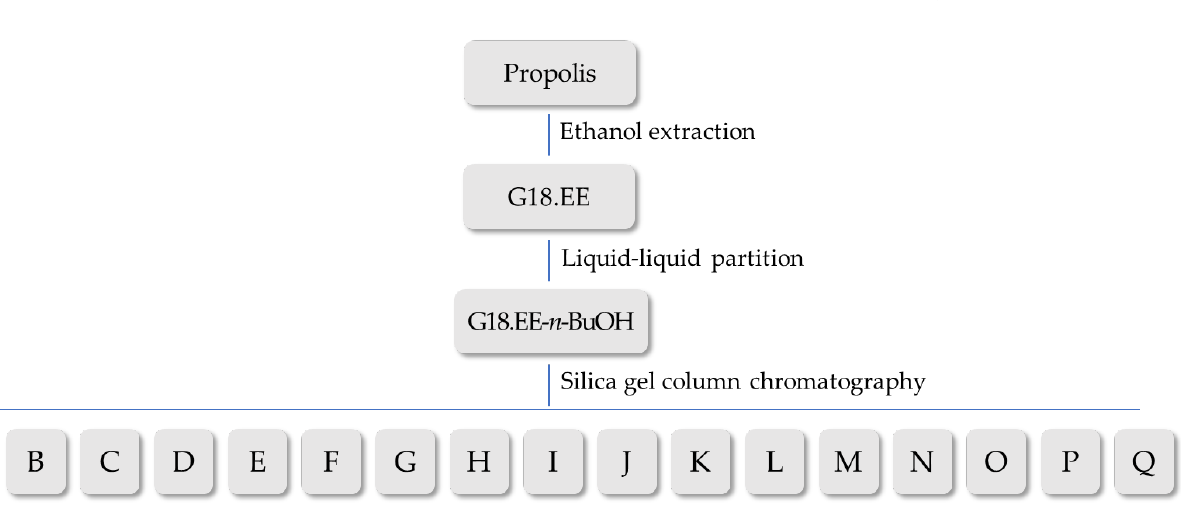
Figure 2. Methodologies used to obtain G18.EE- n -BuOH and the 17 subfractions resulting from its fractionation.